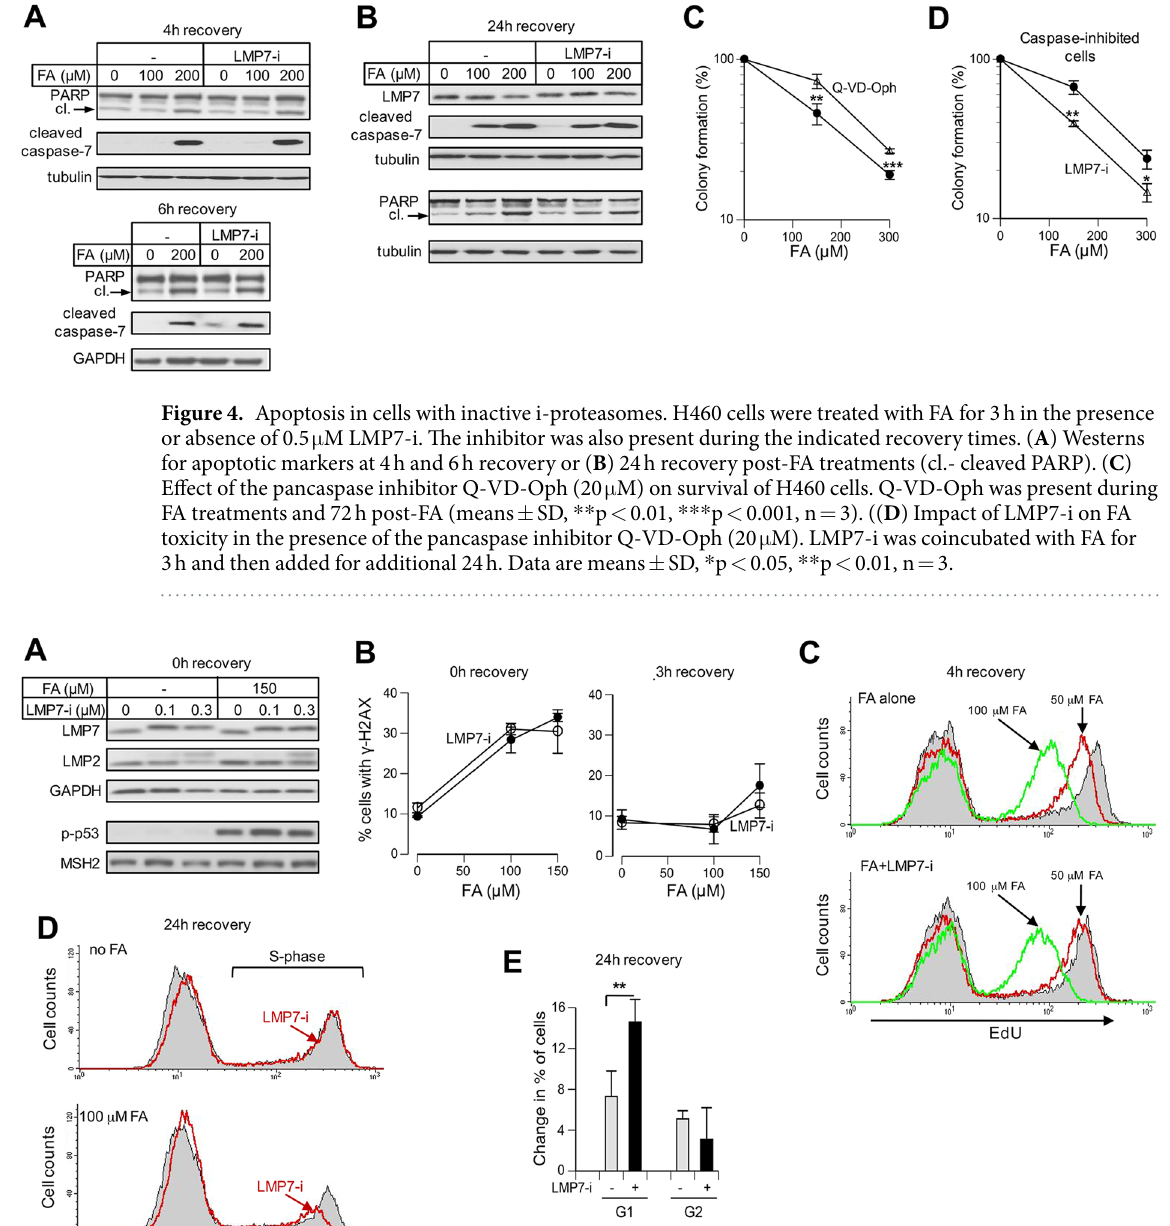
LMP7 band and the higher dose also produced a slower moving LMP2 band (Fig. 5A). In further experiments, we used 0.3 μ M LMP7-i in IMR90 cells. Similar to H460, i-proteasome inhibition in IMR90 cells did not alter early genotoxic responses to FA, such as p53 phosphorylation, γ -H2AX production or DNA synthesis (Fig. 5A–C). However, i-proteasome inactivation impaired a long-term recovery of IMR90 cells from FA damage, resulting in the depletion of S-phase (Fig. 5D) and accumulation of G1 cells (Fig. 5E). Thus, i-proteasomes also play a protec- tive role against FA toxicity in primary human cells.